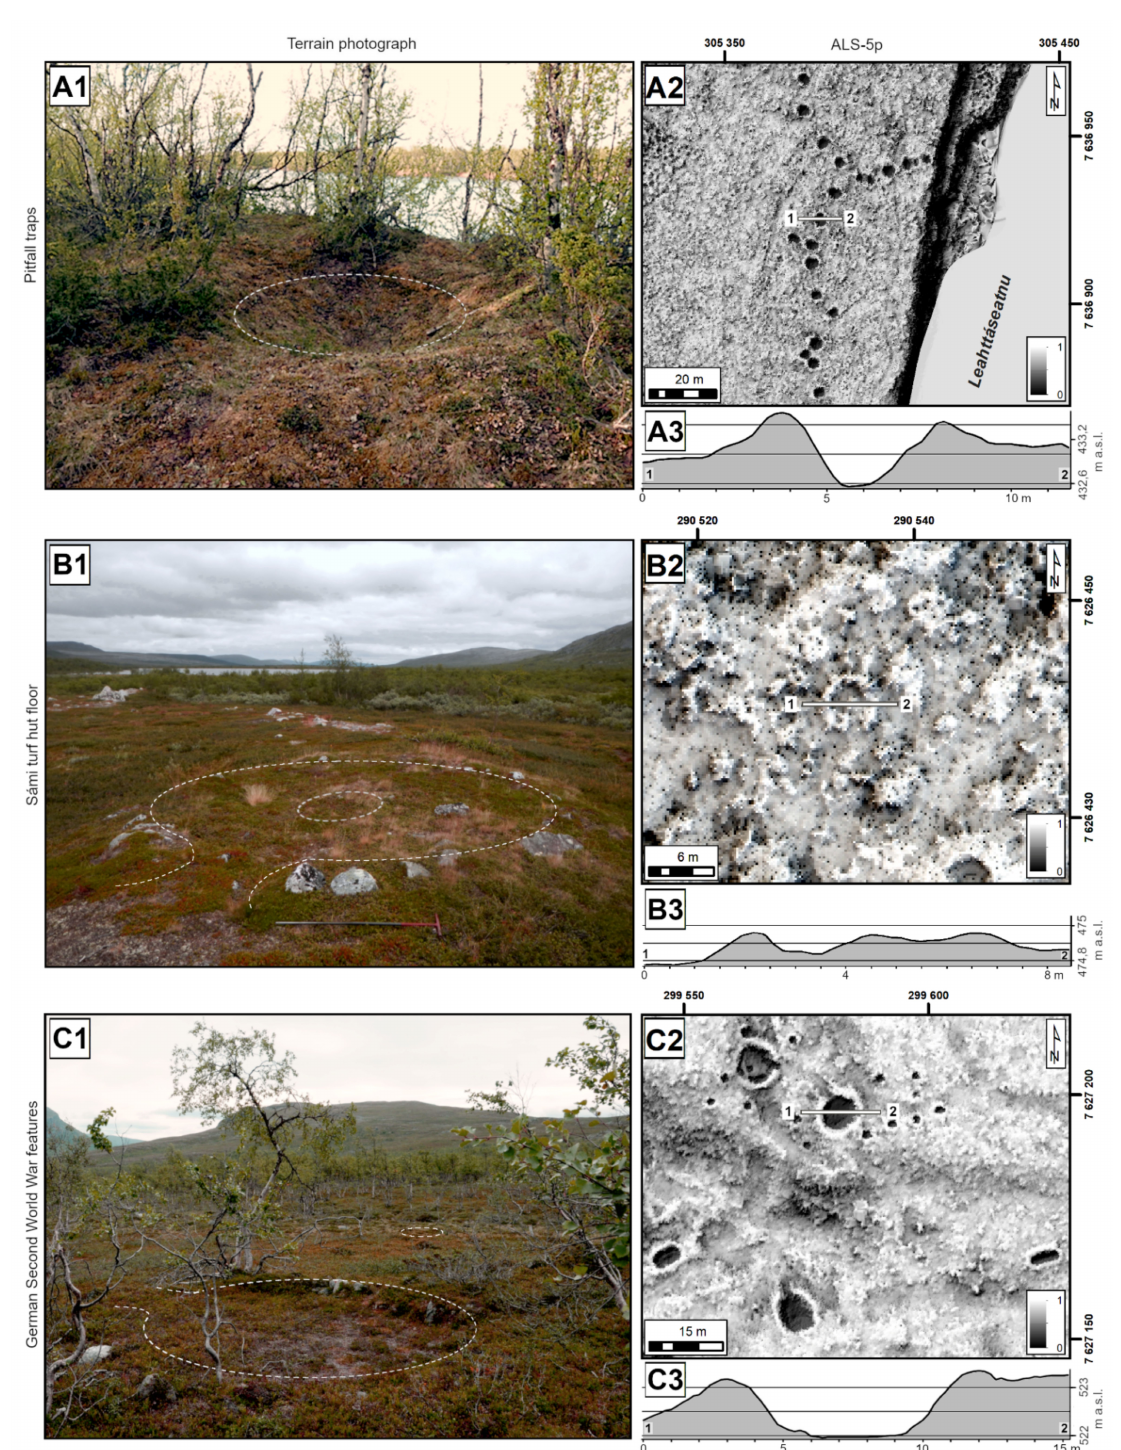
Figure 3. Examples of the archaeological feature types encountered in the study area, in terrain photographs and ALS-5p DEM visualizations (SVF+multi-HS), with feature sections derived from the DEMs [17]. ( A1 – A3 ) Pitfall traps. ( B1 – B3 ) S á mi turf hut floor. ( C1 – C3 ) German Second World War outpost with tent placements, dugouts, rubbish pits, foxholes, and a latrine on the right. (EPSG:3879 ETRS89/GK25FIN). (Illustration and photographs ( B1 – C1 ): Oula Seitsonen, photograph ( A1 ): Sami